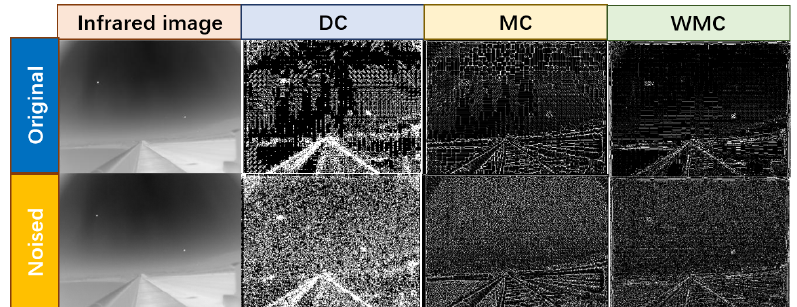
Figure 8. Comparison of noise image and original image.